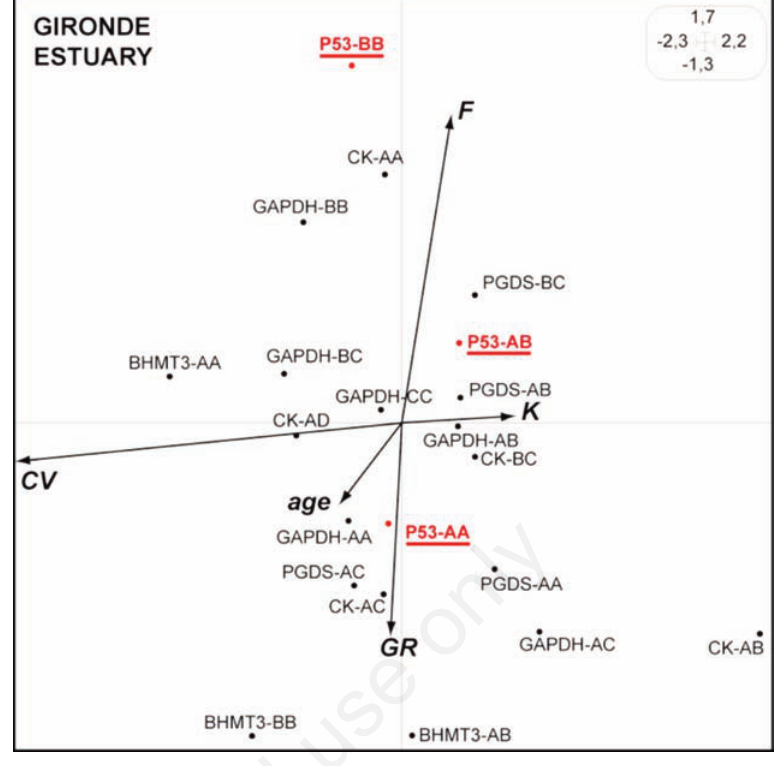
Figure 4. Synthetic Hill and Smith analysis for European flounders from the Gironde estu- ary. The main 2 first axes explain 52% of the total variance. See Figure 1 caption for details.